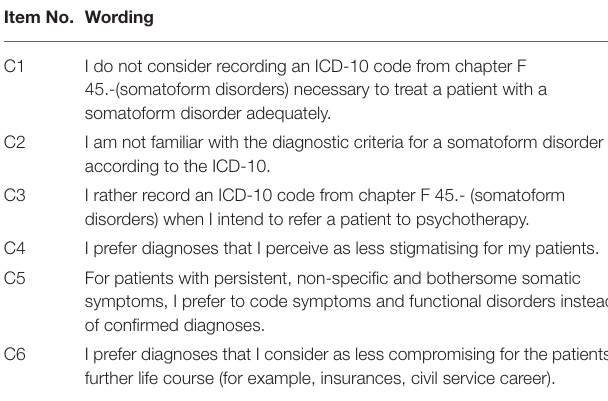
TABLE 1 | Verbatim of coding